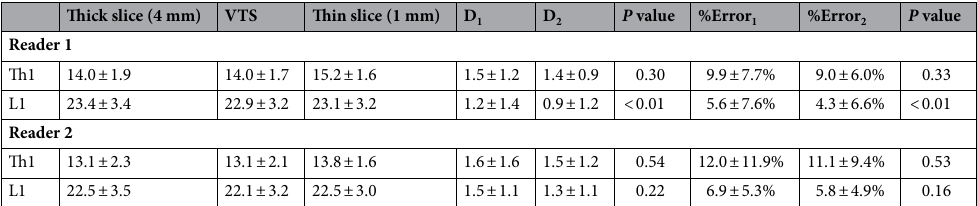
Table 3. Measured heights of thoracic and lumbar vertebrae. Data are mean ± standard deviation (mm, except for %Error